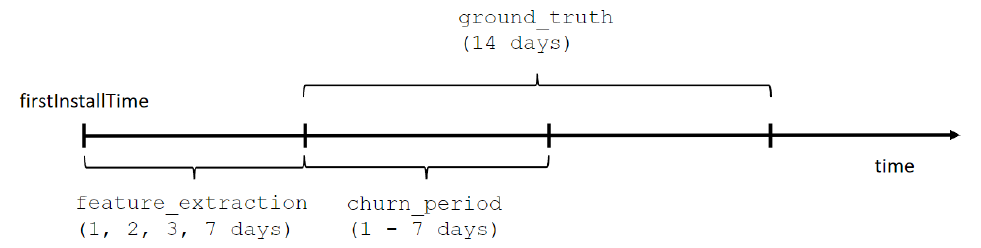
Figure 1. Time constraint